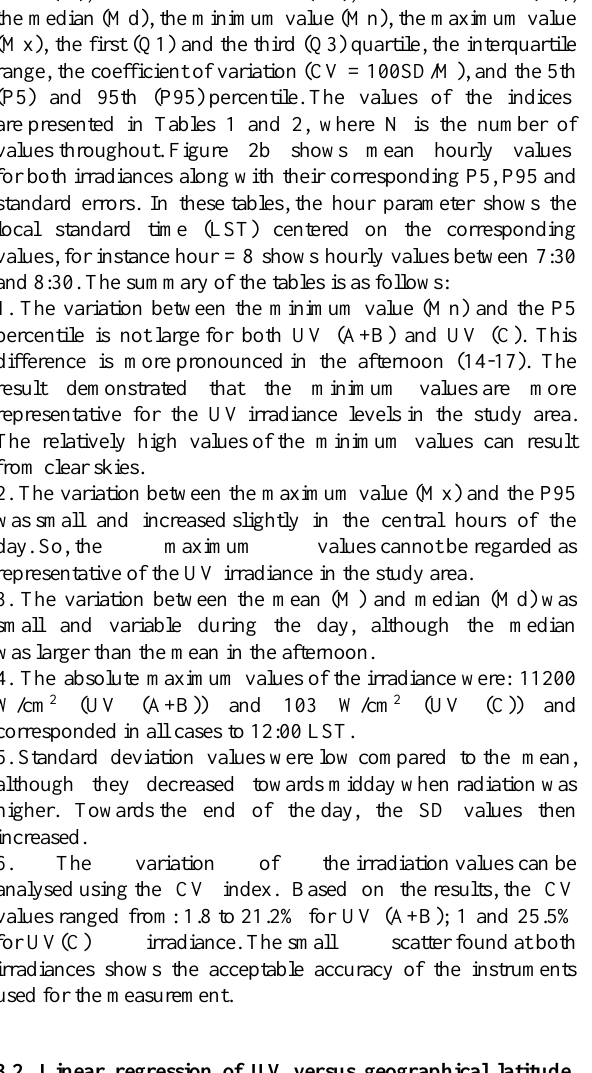
Different kinds of reflective surfaces produce different effects on UV radiation. The distributions of UV (A+B) and UV (C) solar irradiances were examined across different land cover types (Figure 5). The mean UV (A+B) among different